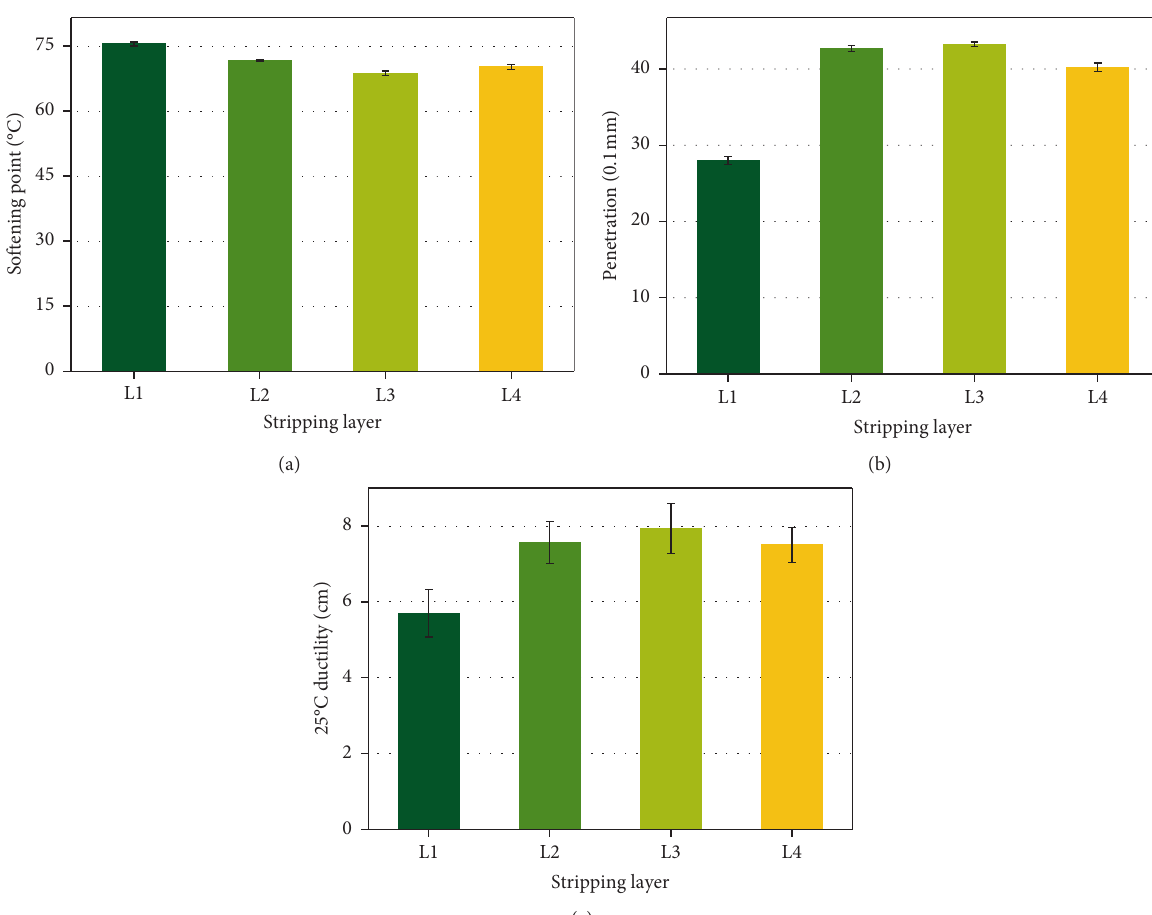
Figure 5: Physical properties of asphalt at different layers: (a) softening point, (b) penetration, and (c)